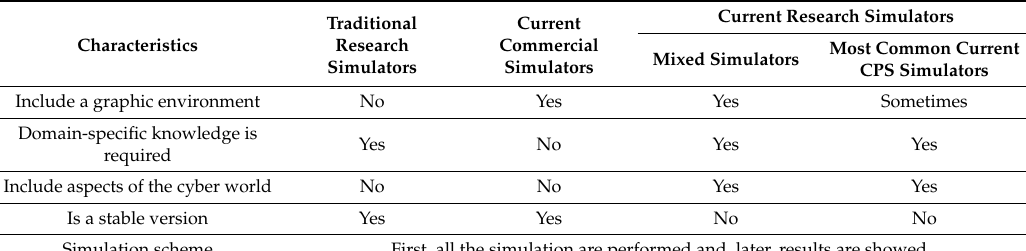
Table 2. Physical processes